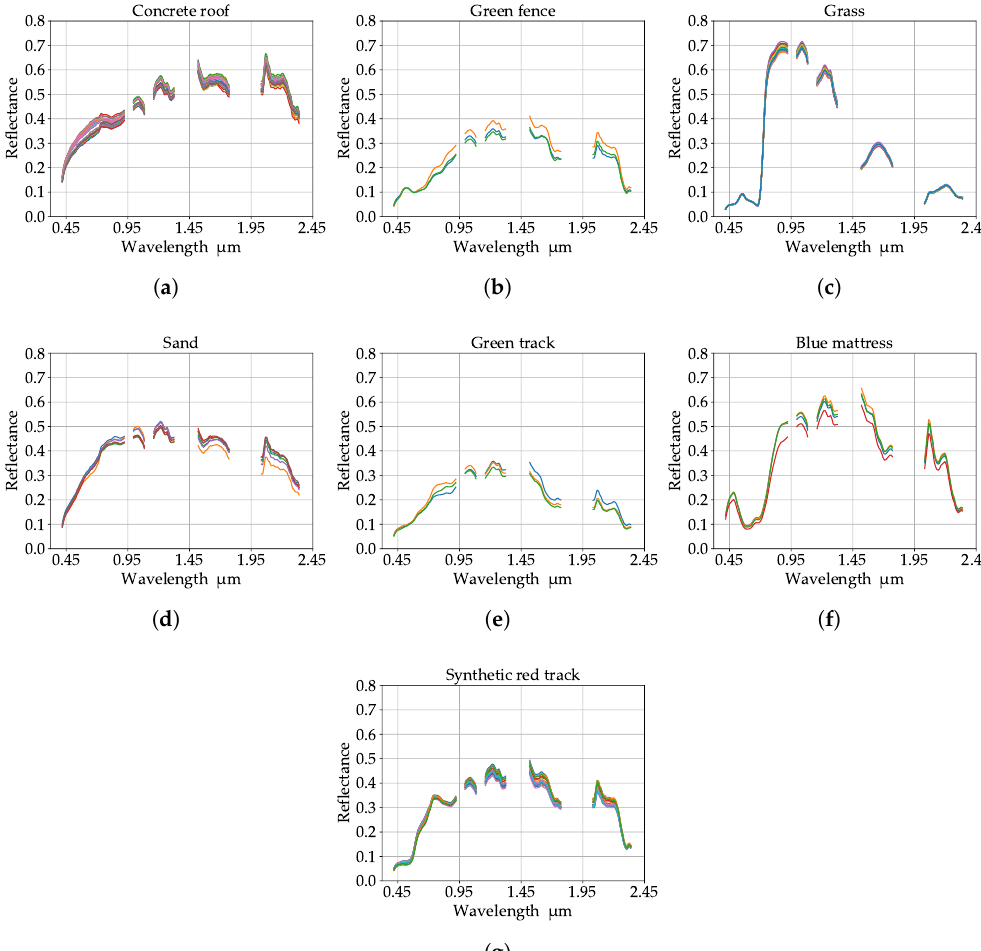
Figure 8. Pure spectra extracted from the Basel image for each class of materials. The material classes are: ( a ) concrete roof, ( b ) green fence, ( c ) grass, ( d ) sand, ( e ) green track, ( f ) blue mattress, ( g ) synthetic red